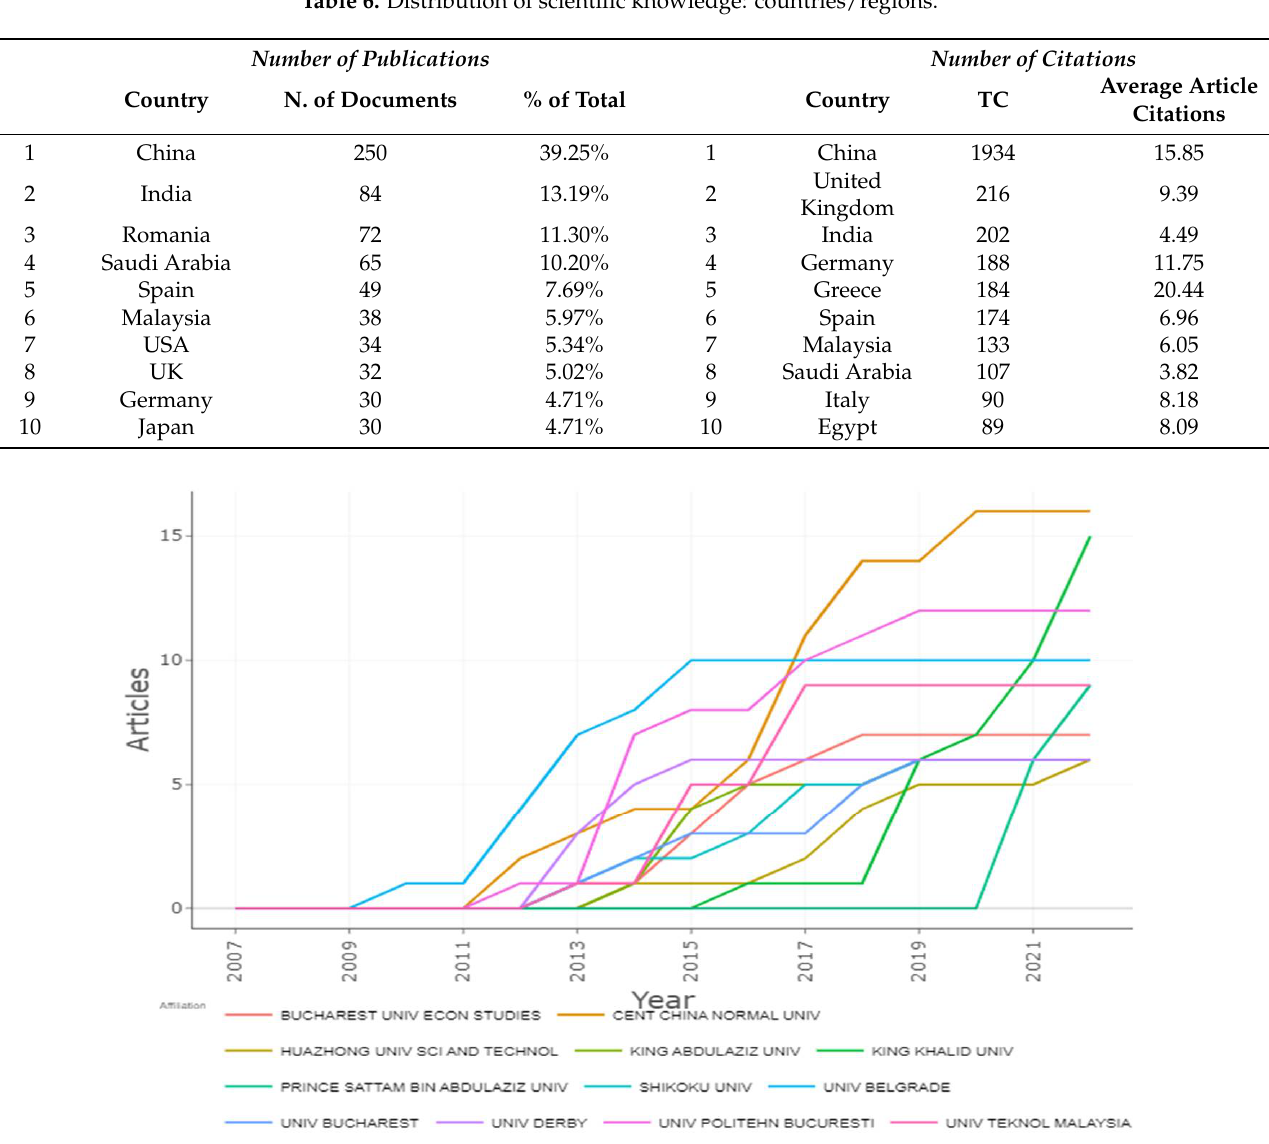
Figure 6. Affiliations’ Production over Time (Source: Biblioshiny).